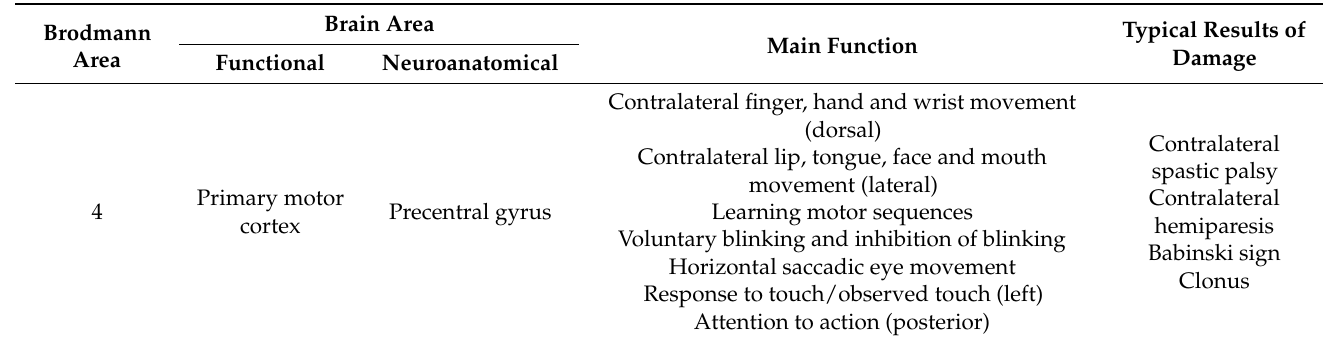
Figure 2. The visual information pathway. The green arrow indicates the dorsal stream, while the red one indicates the ventral stream. LGN—lateral geniculate nucleus. Table 1. Brain regions associated with visual pathways, their location, function and the most common effects of damage